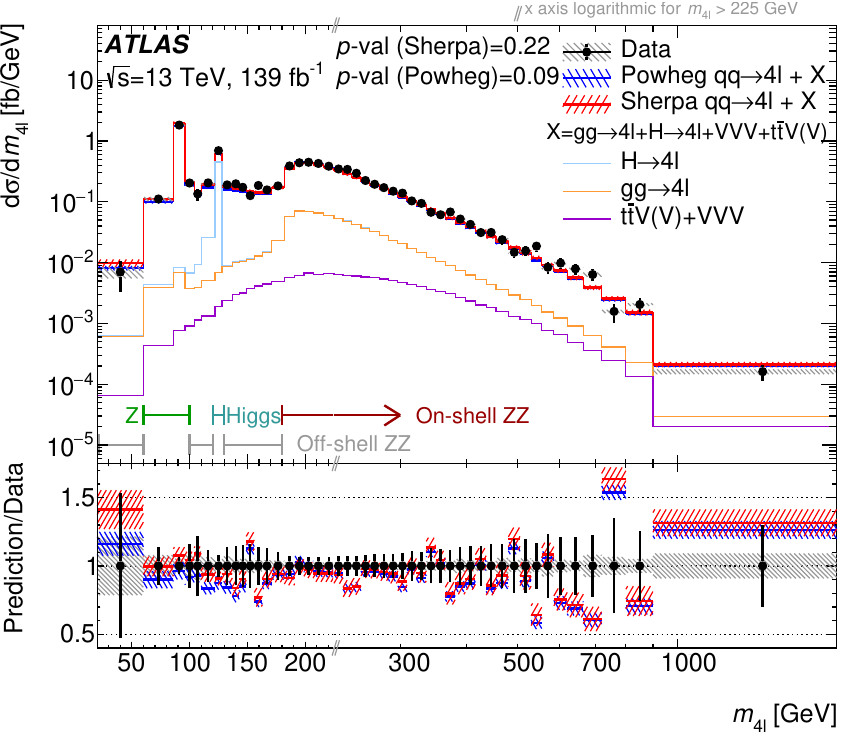
Figure 5 . Differential cross-section as a function of m 4 ‘ . The measured data (black points) are compared with the SM prediction using either Sherpa (red, with red hashed band for the uncertainty) or Powheg + Pythia8 (blue, with blue hashed band for the uncertainty) to model the q ¯ q → 4 ‘ contribution. The error bars on the data points give the total uncertainty and the grey hashed band gives the systematic uncertainty. The breakdown of the contribution from different SM processes is also shown in successive stacked histograms. The short vertical lines terminating horizontal lines indicate the boundaries of the different m regions in which the other variables 4 ‘ are measured. The p -value is the probability for the χ 2 , with the number of degrees of freedom equal to the number of bins in the distribution, to have at least the observed value, given the SM prediction. The lower panel shows the ratio of the SM predictions to the data. The x -axis is on a linear scale until m = 225 GeV, where it switches to a logarithmic 4 ‘